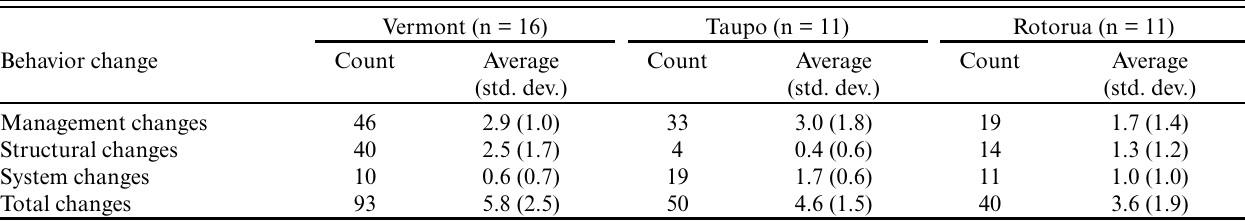
Table 4 . Count of nutrient management changes and average number of behavior changes per person by region.